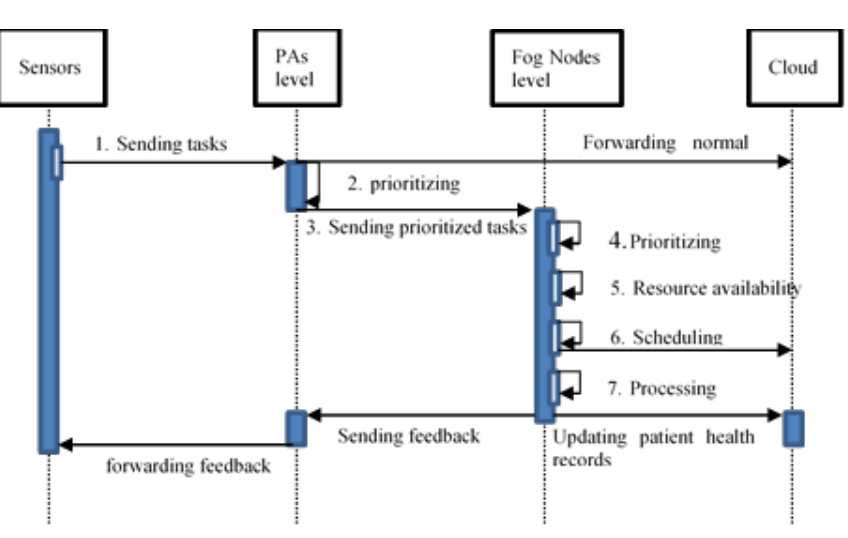
Figure 4. Sequence diagram illustrating the interaction protocol.